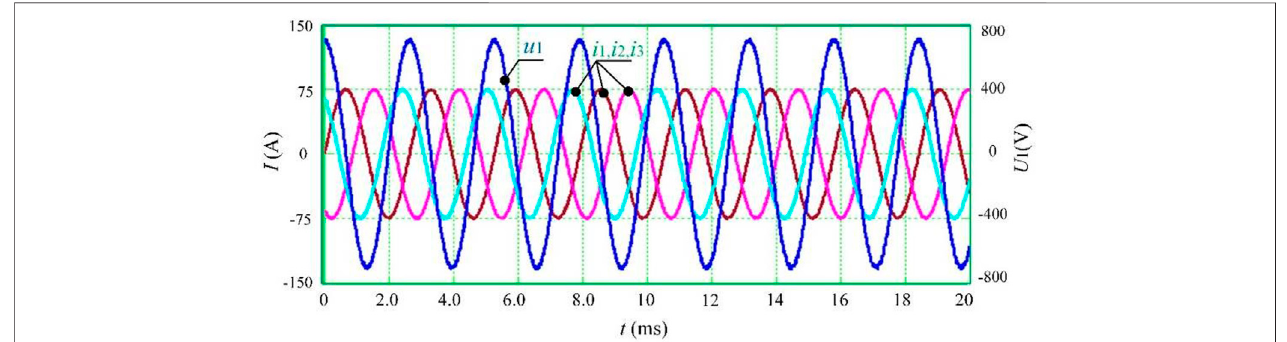
FIGURE 8 | Simulation waveforms of voltage and current in liquid nitrogen ( − 196 °